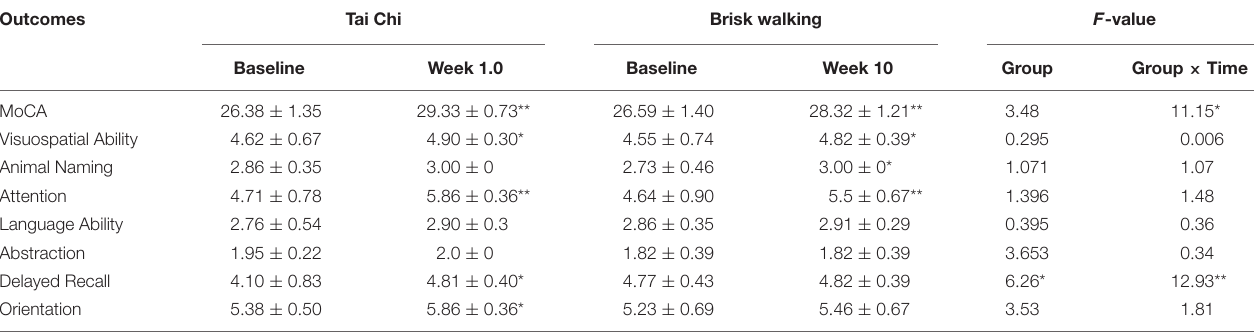
TABLE 2 | Montreal cognitive assessment and its associated sub-domain scores. Outcomes Tai Chi Brisk walking F -value Baseline Week 1.0 Baseline Week 10 Group Group ×